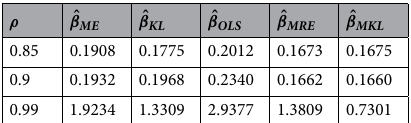
Table 8. Estimated MSE when σ